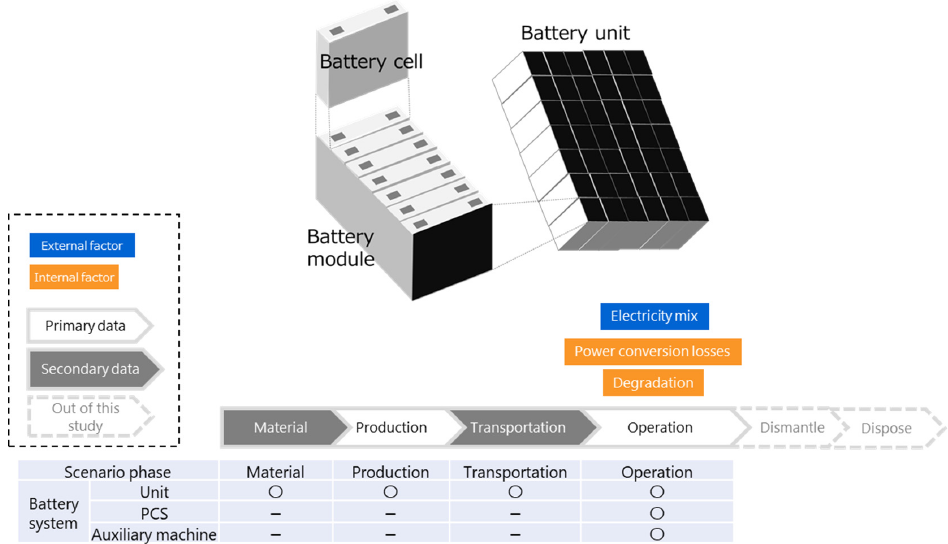
Figure 1. System boundary and individual targeted components.